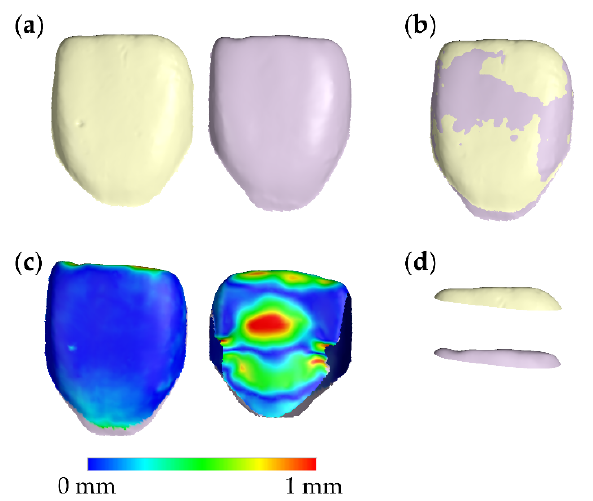
Figure 1. Tooth wear measurement process. ( a ) Corresponding T1 (light yellow) and T2 (light purple) central incisor tooth crowns. ( b ) Best-fit superimposition of the T1 and T2 tooth crowns. ( c ) Buccal and palatal aspects of the color-coded distance map of the superimposed T1 and T2 crowns. ( d ) Corresponding T1 and T2 occlusal crown parts, created following the simultaneous slicing of the superimposed T1 and T2 crowns. The subtraction of these volumes provided the tooth wear measurements used in this study. T1: time point at end of orthodontic treatment. T2: time point on average 13 years after